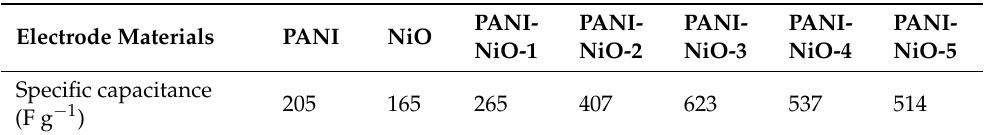
Table 1. Specific capacitance (Cs) of different nano and composite materials at a current density of 1 A g − 1